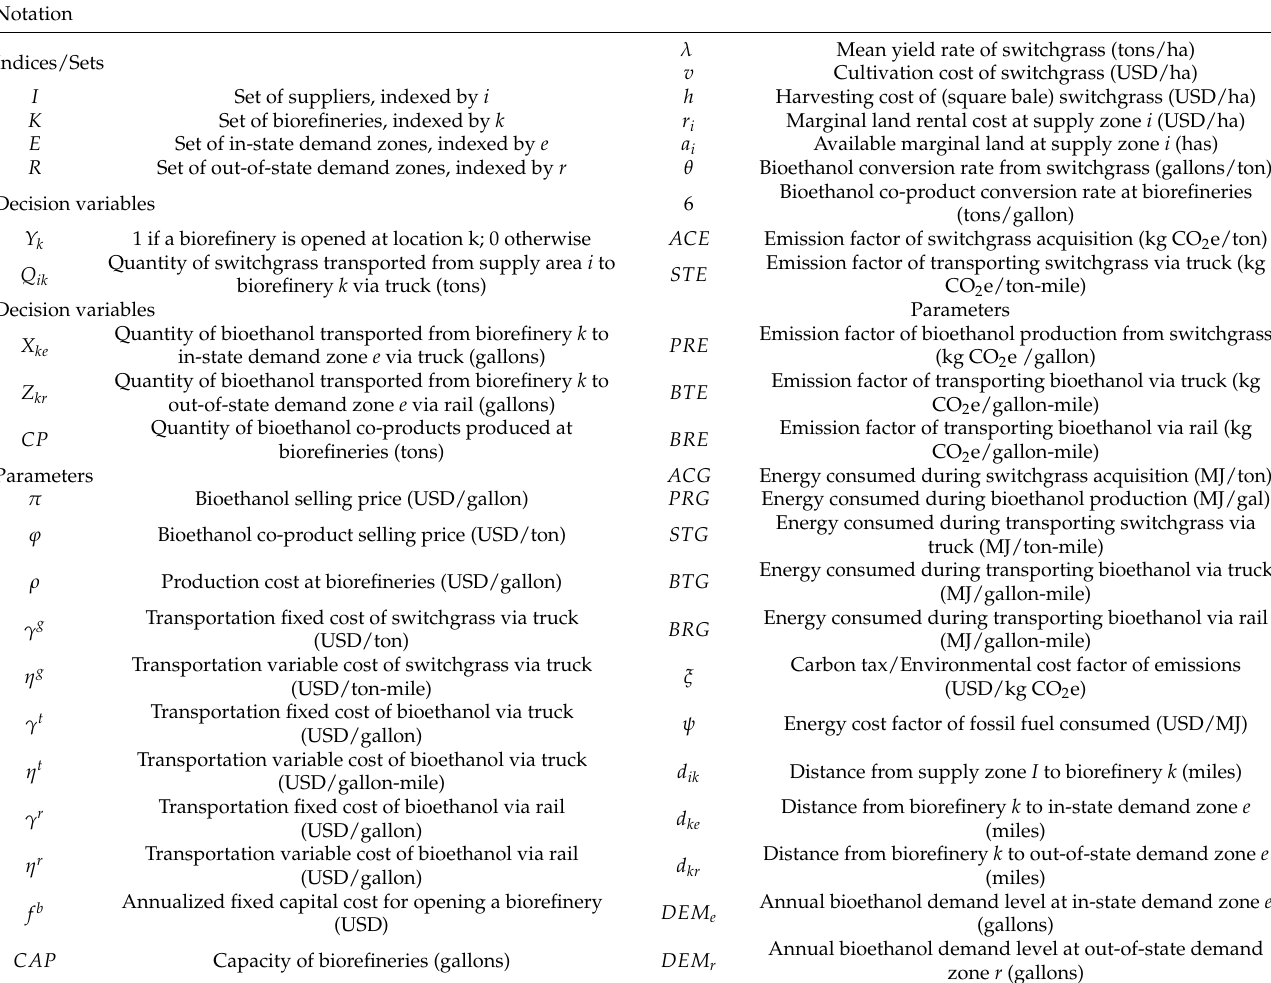
Table 2. Sets, decision variables, and parameters for the